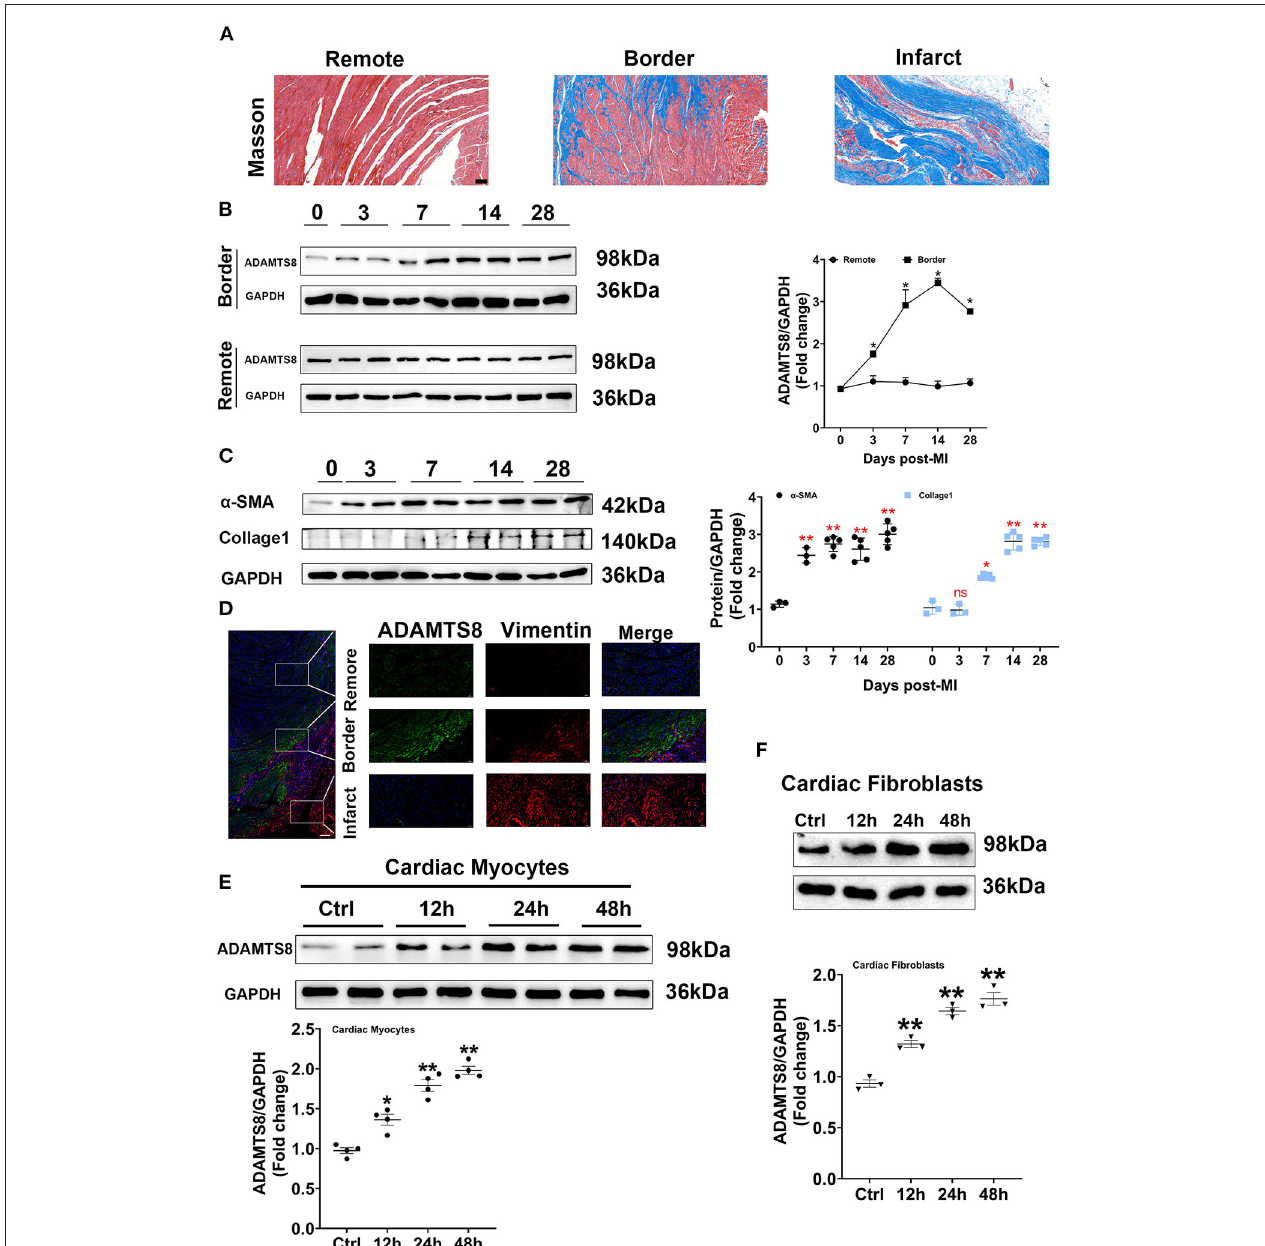
FIGURE 2 | Increased ADAMTS8 expression was associated with cardiac fibrosis in the MI rat model. (A) Representative Masson staining images from the heart of the MI rat model (scale bar = 100 µ m). (B) Changes of ADAMTS8 protein expressions in the border zone and the remote area at the indicated time points post-MI. (C) Western blotting and quantification of the expressions of α -SMA and Collagen I in infarcted and border zones of rat hearts. (D) Representative images of double immunofluorescence staining of ADAMTS8 (green) and vimentin (red) (scale bar = 200 µ m). (E,F) The ADAMTS8 protein level in cardiac myocytes and cardiac fibroblasts under hypoxia conditions for 12, 24, and 48h assessed via western blotting. Data were presented as mean ± SEM. * P < 0.05 vs. 0 day (Sham). ** P < 0.01 vs. 0 day (Sham) or ctrl